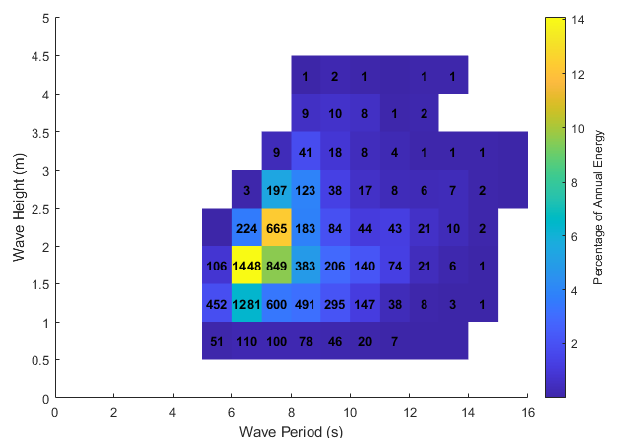
Figure 4: Omni-directional sea state histogram from 2000-2010 at WETS in Oahu, Hawaii (mean annual conditions) The average, 10 th , and 90 th percentile monthly 𝐽 values are shown in Figure 5 . Compared to PacWave, both WETS and Los Angeles show lower gross wave energy flux ( 𝐽 ) and reduced monthly variability. The results shown reinforce the relative reduction in wave energy and wave conditions in lower latitudes – as illustrated in Figure 5 .